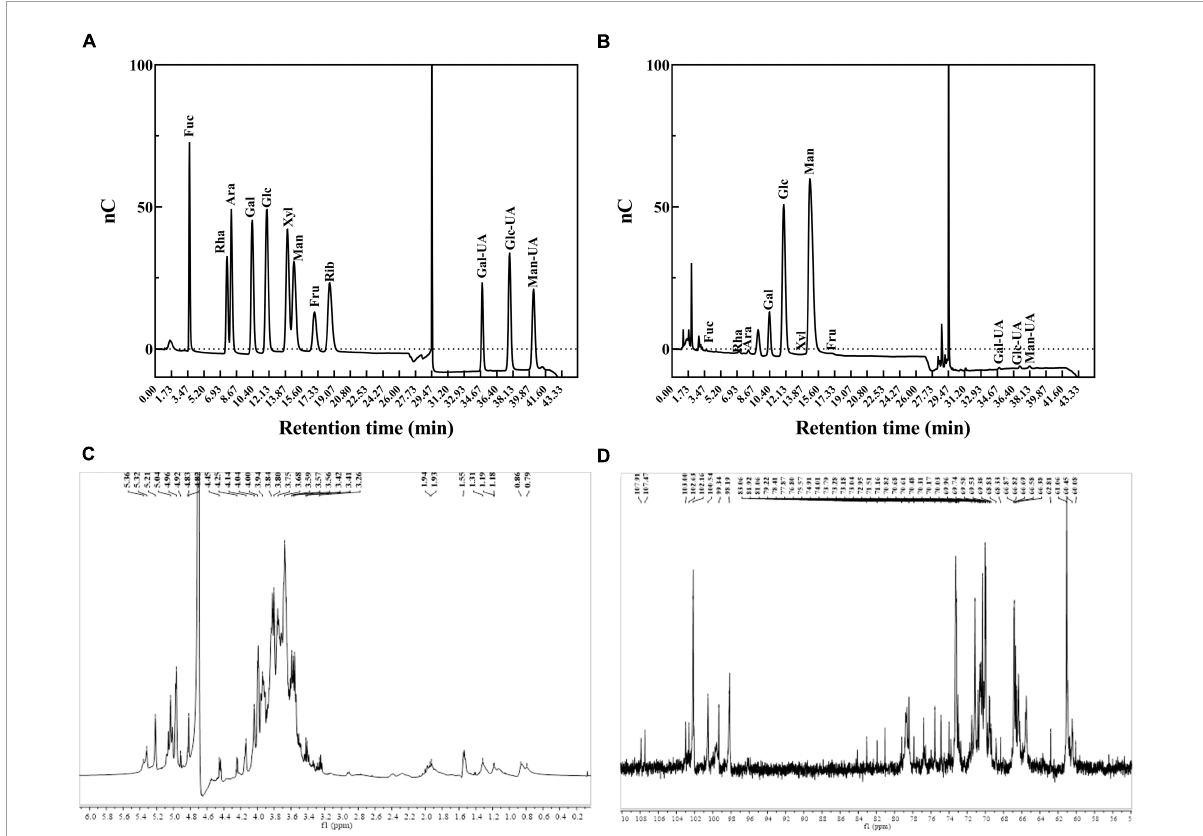
FIGURE3 Monosaccharide composition analysis and nuclear magnetic resonance (NMR) spectra of exopolysaccharides (EPS)-LP2. (A) HPLC analysis of monosaccharide composition of monosaccharide standard product (Fuc, fucose; Rha, rhamnose; Ara, arabinose; Gal, galactose; Glc, glucose; Xyl, xylose; Man, mannose; Fru, fructose; Rib, ribose); (B) HPLC analysis of monosaccharide composition of EPS-LP2; (C) 1 H nuclear magnetic resonance (NMR) spectrum; (D) 13 C NMR spectrum.